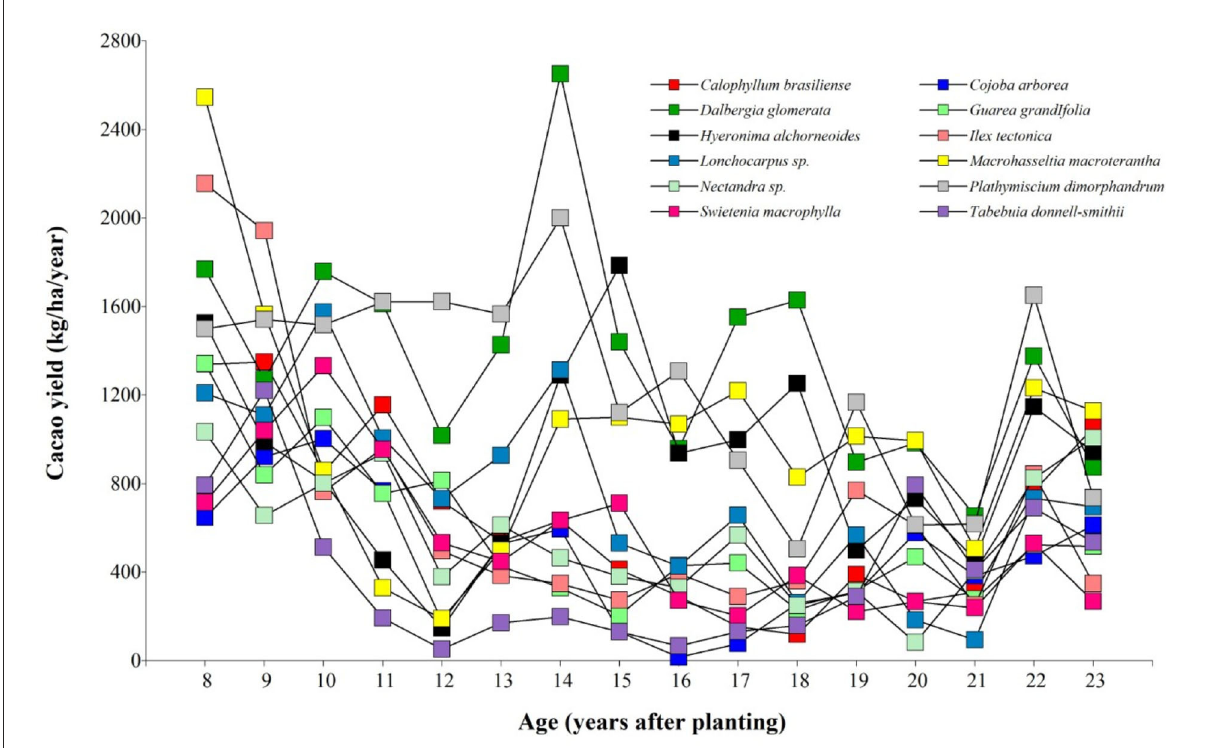
FIGURE5 Yield (kg ha − 1 year − 1 ) evolution curves of cacao grown under 12 timber-based agroforestry systems in the experimental site “CEDEC-JAS”, La Masica, Atlántida,